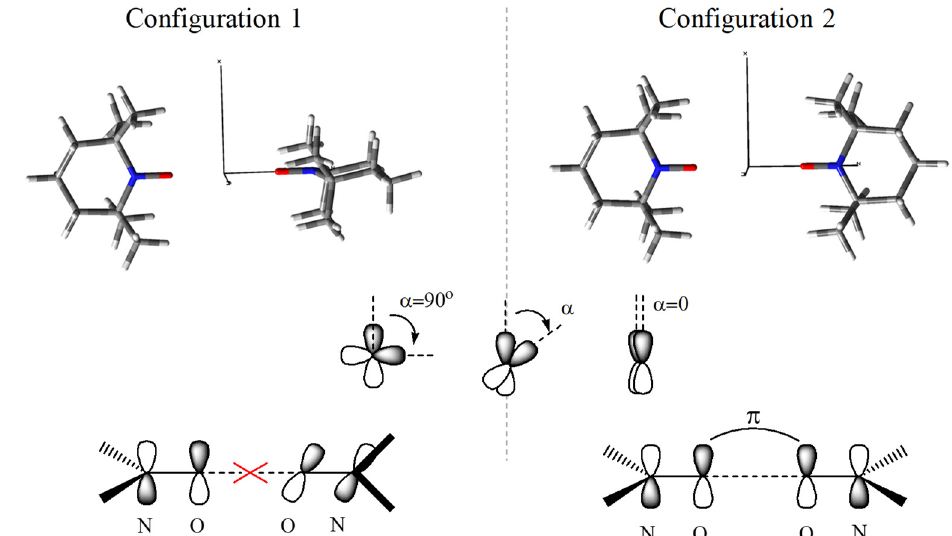
Figure 1. Scheme of molecular orientations and orbital overlap patterns, imposing co-linear NO groups in a TEMPO dimer, labelled “Configuration 1” (left side) and “Configuration 2” (right side). The middle inset suggests the general angle between p-type orbitals viewed along the common N-O axes. The red color is for the oxygen atom, blue for nitrogen, white for hydrogen and grey for carbon.